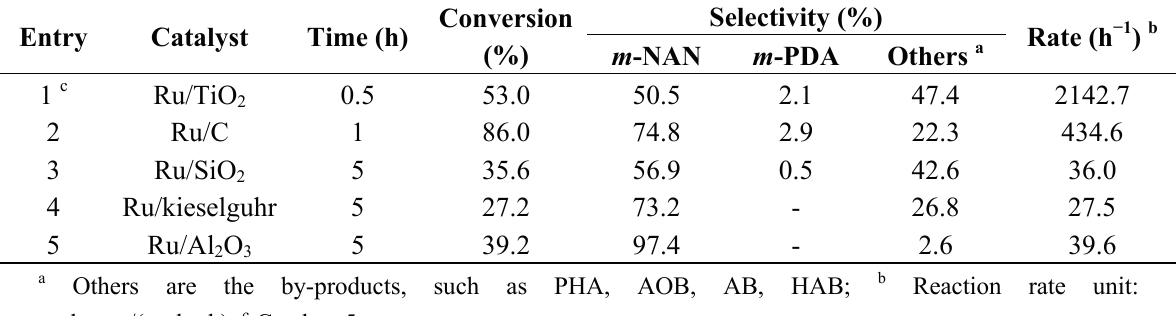
Table 1. Results for the hydrogenation of m -DNB over supported Ru